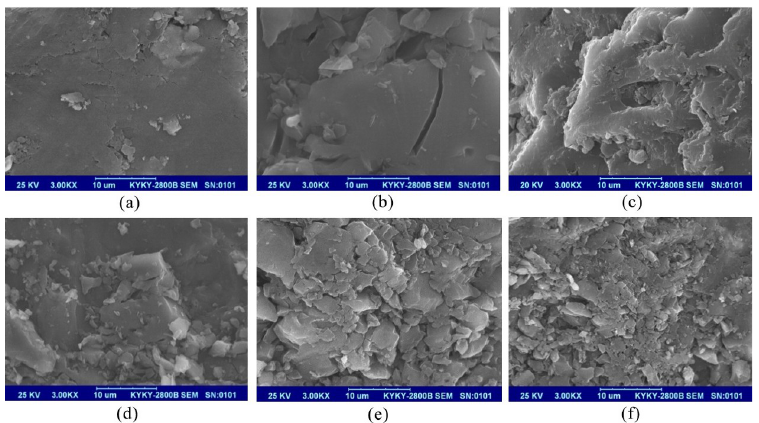
Fig 15. SEM test results of coal samples with different blasting parameters. (a)Original coal sample.(b)Group 1 coal sample.(c)Group 2 coal sample(d)Group 3 coal sample.(e)Group 4 coal sample.(f)Group 5 coal sample.